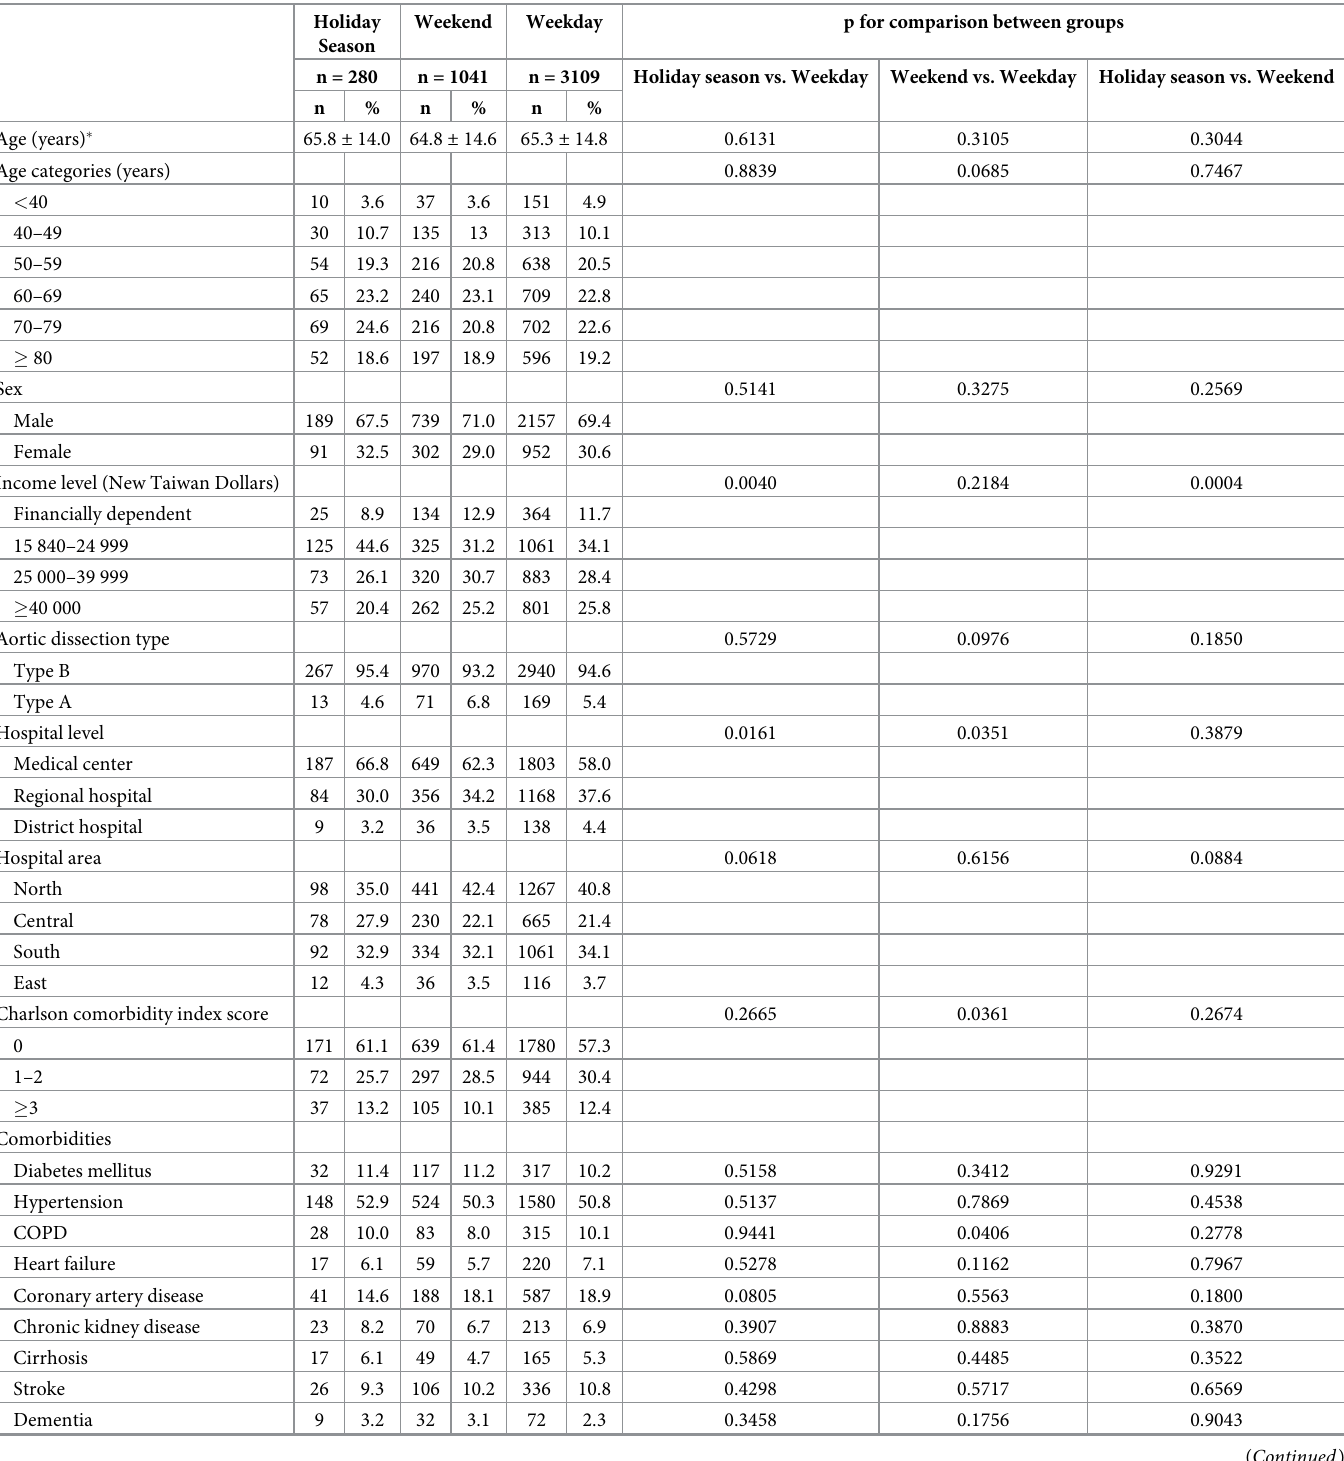
Table 1. Baseline characteristics of patients admitted during the holiday season, weekend, and